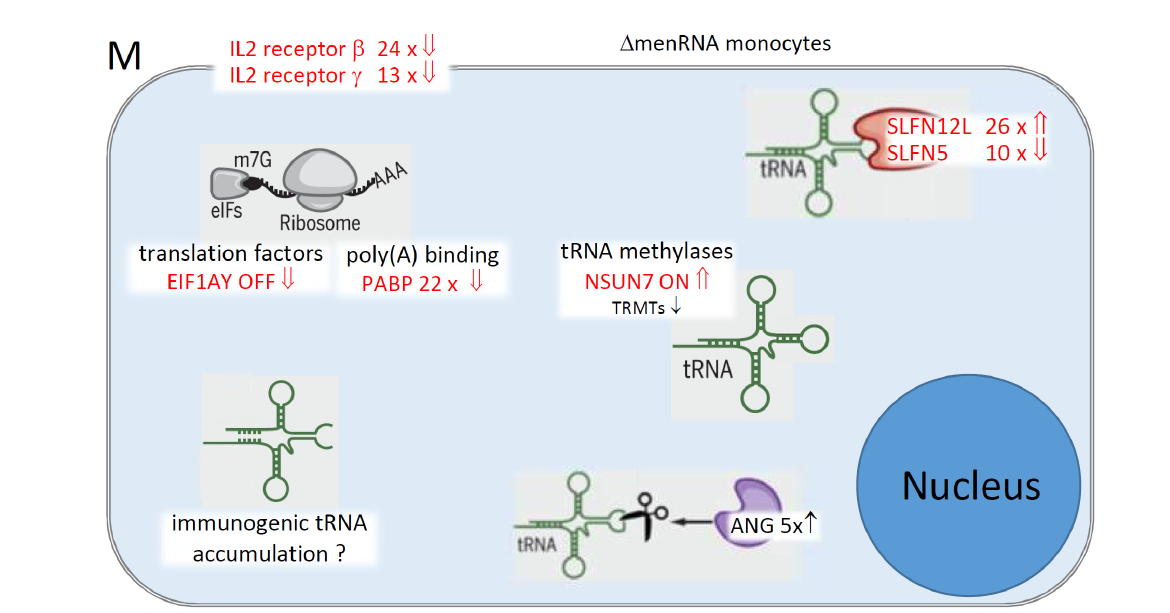
Figure 3. Disturbances of innate immune sensing, transcription, and translation in defective mono- cytes. Panels ( A – E ) (Innate immune sensing): A key finding of the RNA-seq was imbalance between multiple innate immune sensors in ∆ menRNA cells under baseline (panel ( A )) and LPS-stimulated (panel ( B )) conditions (Table S1A). The color bars associated with the rainbow plots in panels ( A – C , G – I , J – L ) represent FPKM values. Amongst cytosolic receptors, NOD2 [21] was ~8-fold- and CIITA [35] ~17-fold-induced, whereas NLR-class receptors NLRC3, NLRC4, NAIP, and MEFV were suppressed in ∆ menRNA monocytes. Amongst membrane-bound Toll-like receptors, TLR 2 showed ~10-fold elevated baseline expression in ∆ menRNA cells (compare Figure 5A). In contrast, defective induction was seen for TLR6, TLR1, TLR8, TLR10, and TLR7 in ∆ menRNA upon LPS challenge (panel ( B )). Twist family bHLH transcription factor 2 (TWIST2) [26] was ~10-fold down in these ∆ menRNA cells (panels ( G , H )), and loss of NLRC3 and TWIST2 expression in ∆ menRNA monocytes could not be rescued by LPS (panel ( E ), compare Figure 6A for related findings in macrophages). mascRNA cells likewise displayed anomalies in immune sensor expression (panel ( C )) (Table S2A), however different from those observed in ∆ menRNA cells. Prominent in ∆ mascRNA monocytes was the induction of interferon (IFN)-induced transmembrane (IFITM) proteins which represent primary cellular defenses against multiple viruses [27]. Upon PMA-induced differentiation of ∆ menRNA and ∆ mascRNA monocytes into macrophages, multiple further baseline anomalies of antiviral defense genes became apparent (Supplementary Figure S9). In both defective clones, there was imbalance of apoptosis-related genes. In LPS-stimulated ∆ menRNA cells (panel ( B )) apoptosis regulator BOK and Niban apoptosis regulator FAM129C were upregulated, whereas serine/threonine kinase RIPK3 and apoptosis inhibitors NAIP and CARD14 were suppressed here. In ∆ mascRNA cells (panel ( C )), NAIP was induced while apoptosis-enhancing nuclease AEN [36] was ~3.-fold- and p53 apoptosis effector PERP [37] ~5.1-fold-suppressed (Table S2A). In addition to alterations of protein-coding genes, RNA-seq identified deregulation of long noncoding RNAs (lncRNAs) and antisense (AS) RNAs in ∆ menRNA and ∆ mascRNA monocytes (Table S1D/Table S2D). Thus, ∆ menRNA cells showed ~7-fold downregulation of a recently discovered novel transcript designated ’MARCKS cis-regulating lncRNA promoter of cytokines and inflammation’ or ‘regulator of cytokines and in- flammation’ (ROCKI) (see Figure 4D,E) (Table S1D/Table S2D). Panels ( F – I ) (Transcriptional level): Several transcription factors (TF), nuclear factors and epigenome modifiers were deregulated in defective cells. At the transcriptional level, in addition to TWIST2, TF GATA2 was ~4-fold-induced and GATA6 ~20-fold-suppressed, and NFATC2 switched off in ∆ menRNA cells (panels ( G , H ))